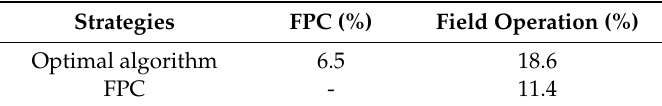
Table 5. Energy-saving ratio comparison of the three